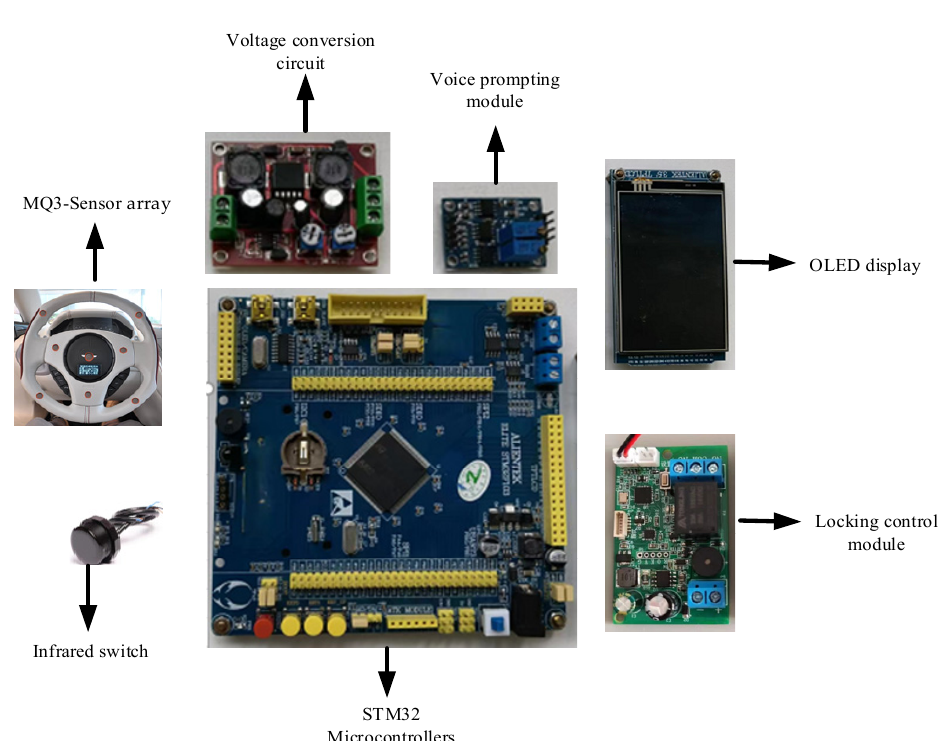
Figure 4. Hardware design of the device: STMicroelectronics manufactures the STM32 microcon- troller, model number STM32F103ZET6; the MQ3 gas sensor is manufactured by YouXin Elec- tronic, model number MQ3-1, and is made of tin dioxide; the infrared switch is manufactured by Xingkechuang, model number XKC-KD200; the voice chip manufacturer is Information Systems Development (ISD), model number ISD4004; the display is an OLED display of 1.3 inches, manu- factured by Telesky; manufacturer of the relay is Tengfei, model number is JQC-T78-DC5V-C. The model number of ISD4004 is assigned by Information Systems Development; the display is an OLED display of 1.3 inches, manufactured by Telesky. The relay is manufactured by Tengfei and has the model number